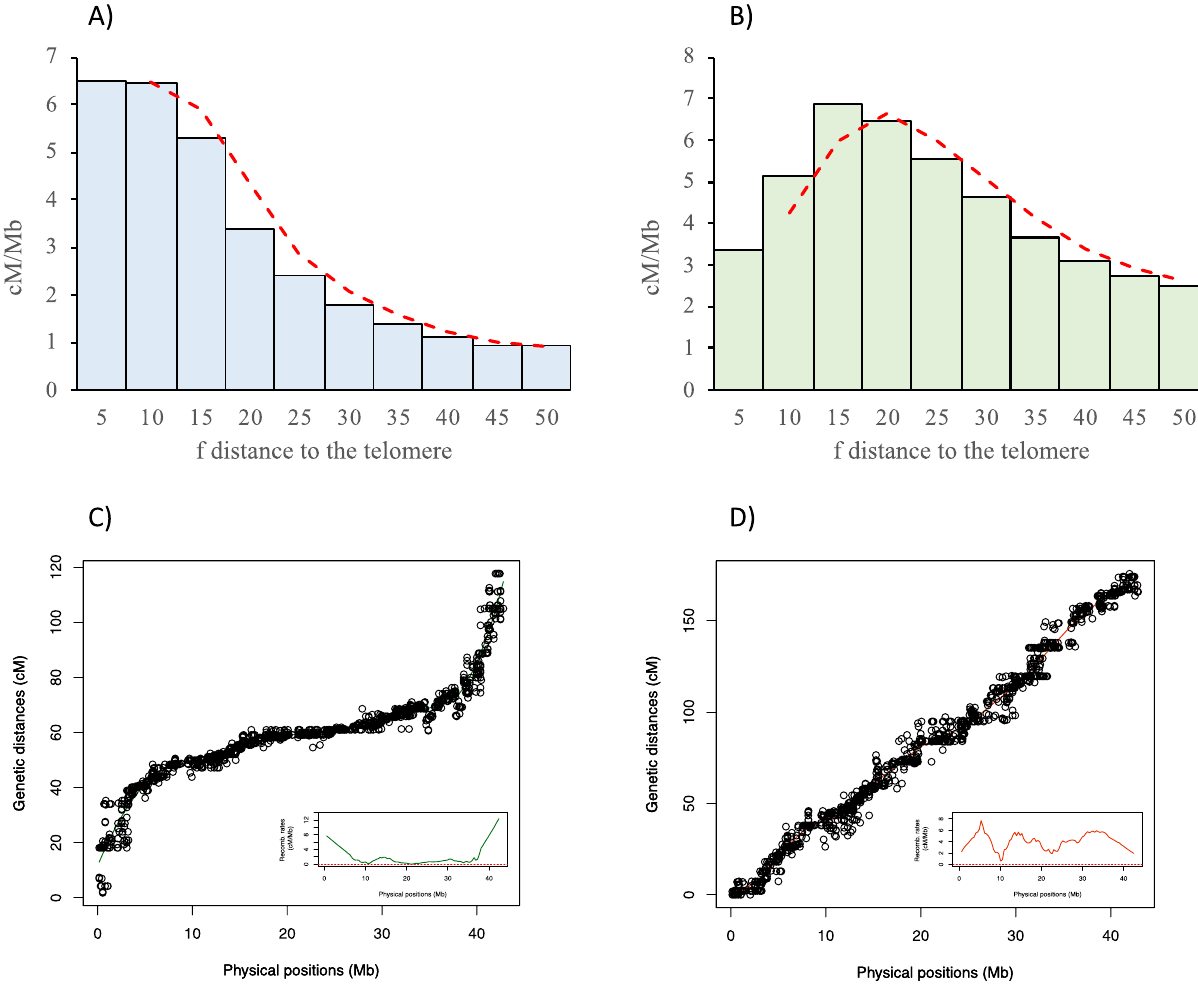
Figure 5. Recombination landscape averaged across linkage groups for ( A ) male and ( B ) female. The recombination rates (cM/Mb) and the relative distance from the nearest telomere scaled by the chromosome length (f) is represented. The red dashed line indicates the observed tendency. Panels ( C , D ) show the relationship between physical and genetic distances for SseLG1 in male and female, respectively. The square inside the panels ( C , D ) show the specific recombination landscape. The complete information for all SseLGs is shown in Supplementary Fig. S2 and